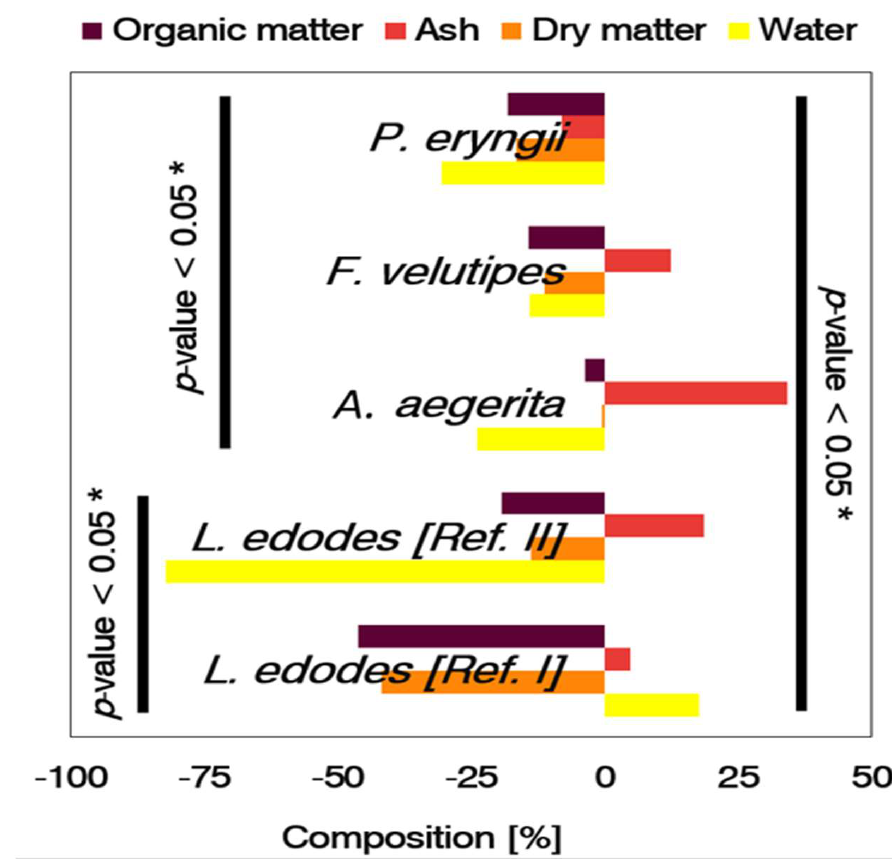
Figure 2. Proximal analysis of the substrate by exotic mushrooms relative to L. edodes with (Ref. I) and without (Ref. II) hydration as a supplementary level of management. The bars show the fluctuation in the composition of the substrate between the beginning and end of cultivation. The larger the bar, the greater the compositional distinctiveness of the spent mushroom substrate relative to the precursor material. Significance: * p -value < 0.05.